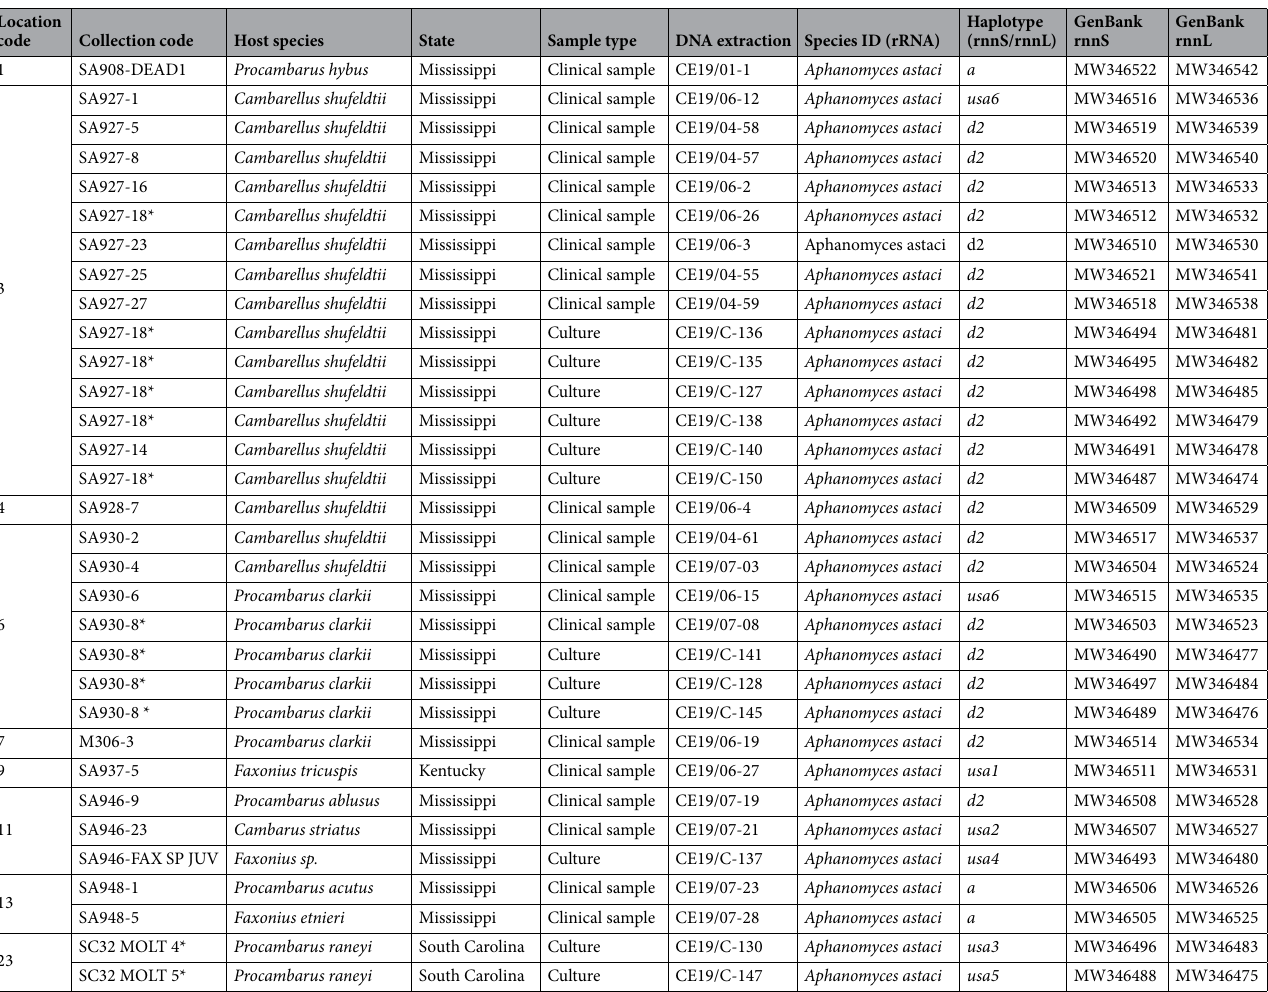
Table 1. Location and samples ID of the of the crayfish species analyzed for Aphanomyces astaci haplotypes. North American crayfish species from each of the analyzed locations (Location code:1–30), including the corresponding collection codes, state, sample type (clinical sample/culture), DNA isolation code (CE19/), BLAST species ID, result of the mitochondrial rnnS/rnnL haplotype and GenBank references for the rnnS and rnnL regions. NA: not applicable. Each unique collection code refers to an individual crayfish. *Different pieces from the same